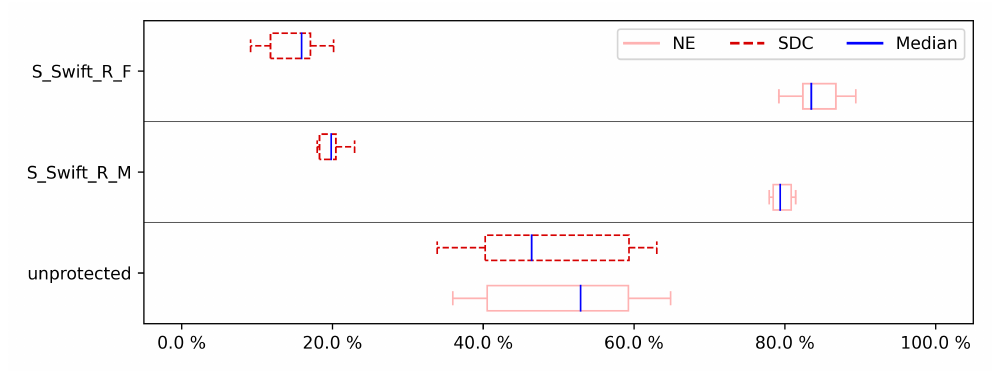
Figure 4. DFE fault injection results for 1 register.